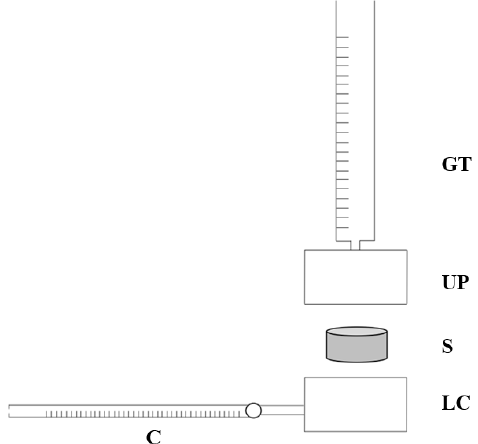
Figure 3. Scheme of the custom-made permeability set-up. Shown in the figure are the graduated tube ( TG ), upper ( UC ) and lower ( LC ) chambers, capillary ( C ), and scaffold sample ( S ).